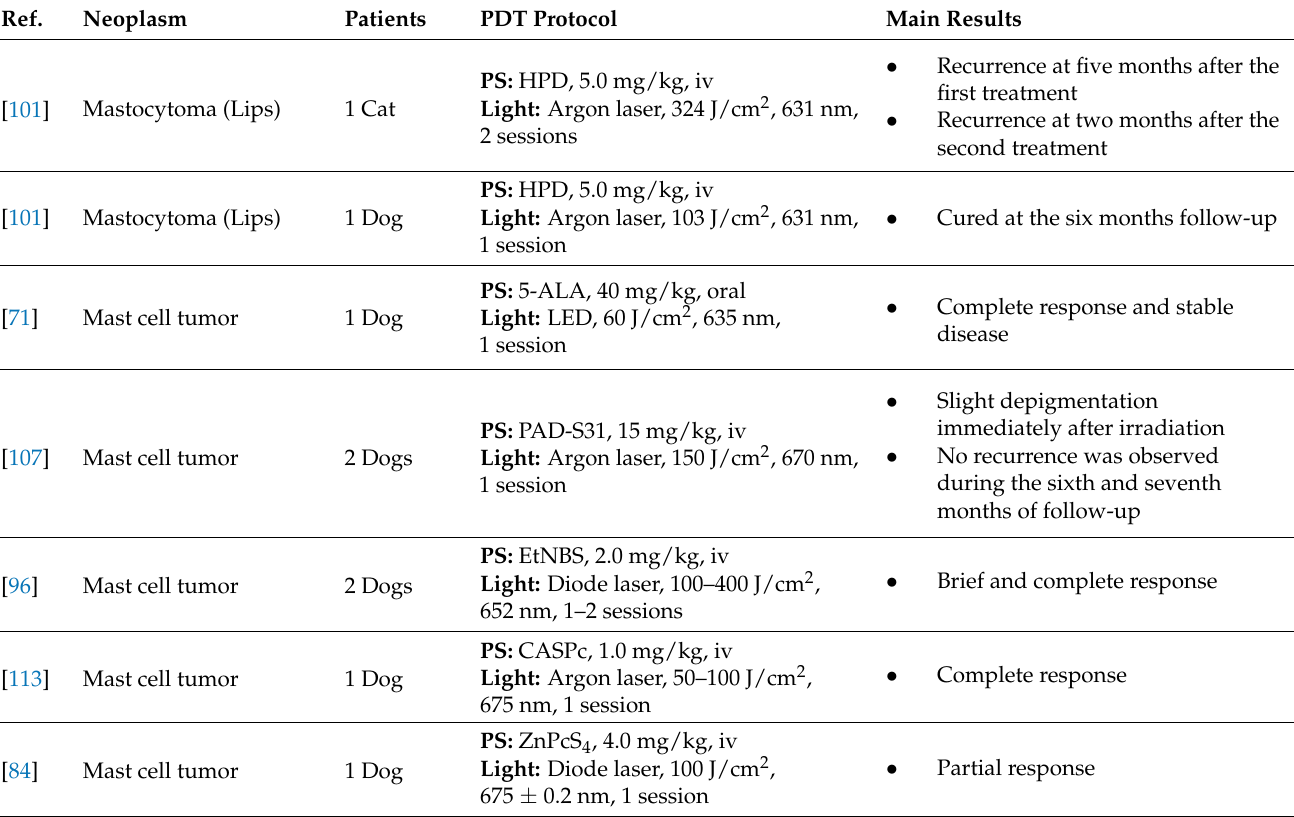
Table 2. Clinical studies on PDT in animals with